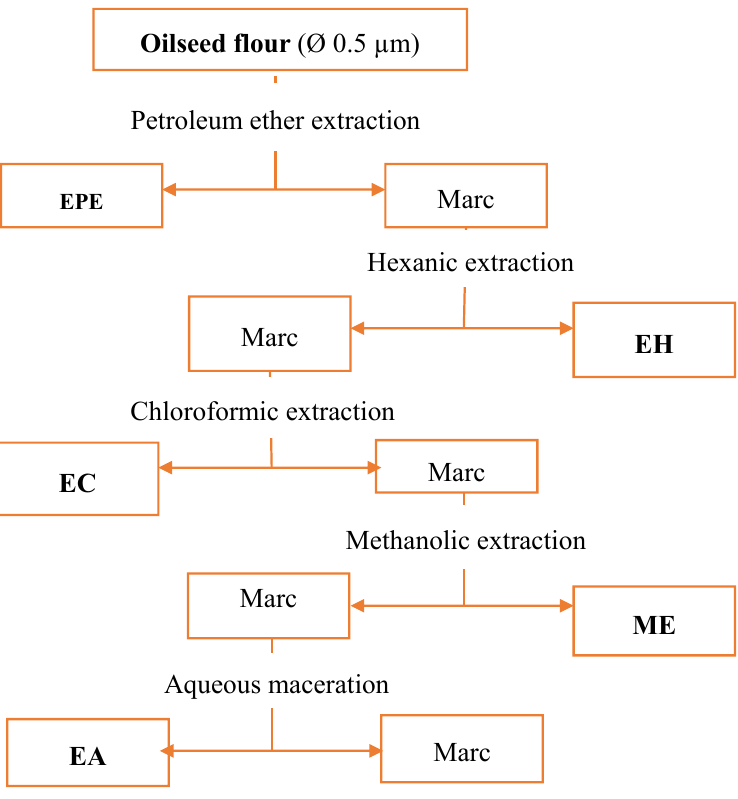
Figure 1. Soxhlet extraction diagram (successive exhaustion of phyto-components). EPE: petroleum ether extract; EH: hexane extract; EC: chloroform extract; ME: methanol extract; EA: aqueous extract.